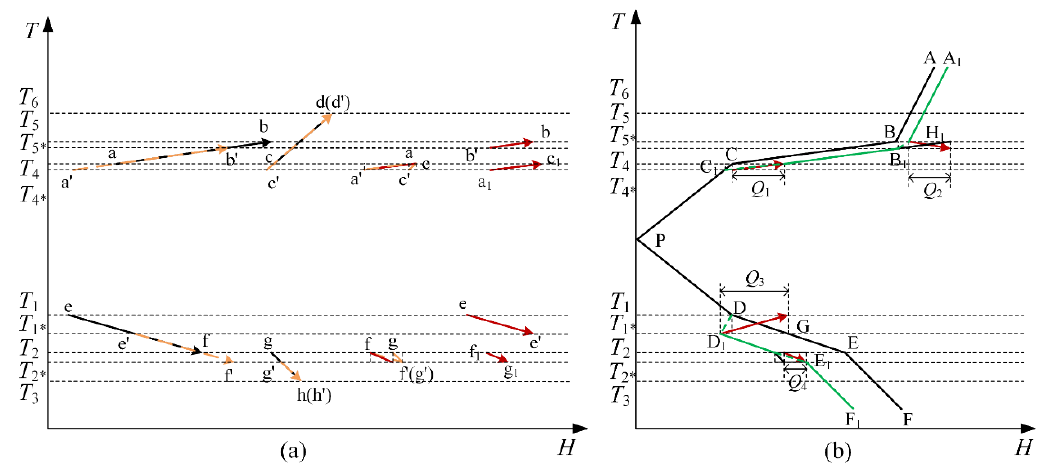
Figure 2. Variation of streams and the grand composite curve (GCC) for Case 1: ( a ) Variations of the streams; ( b ) Variation of GCC.